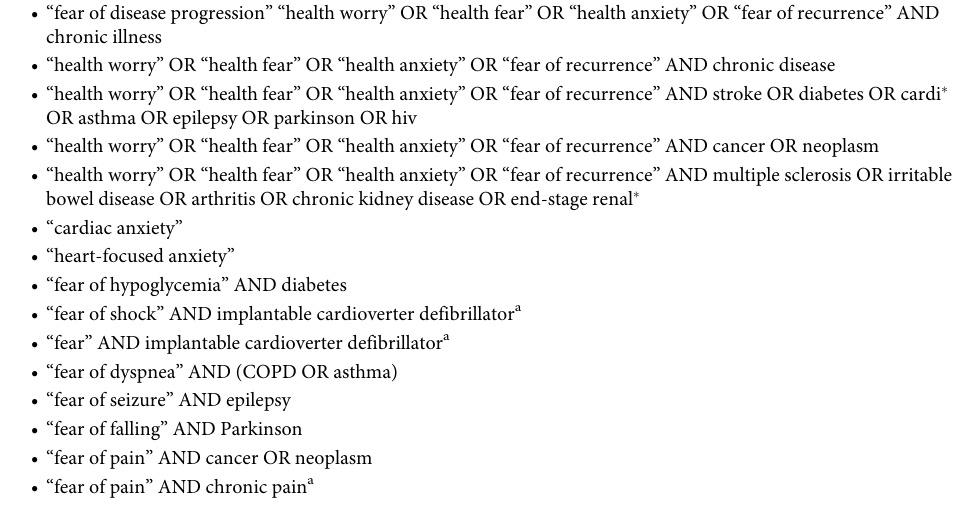
Table 1. Complete list of keywords by illness type used for the database